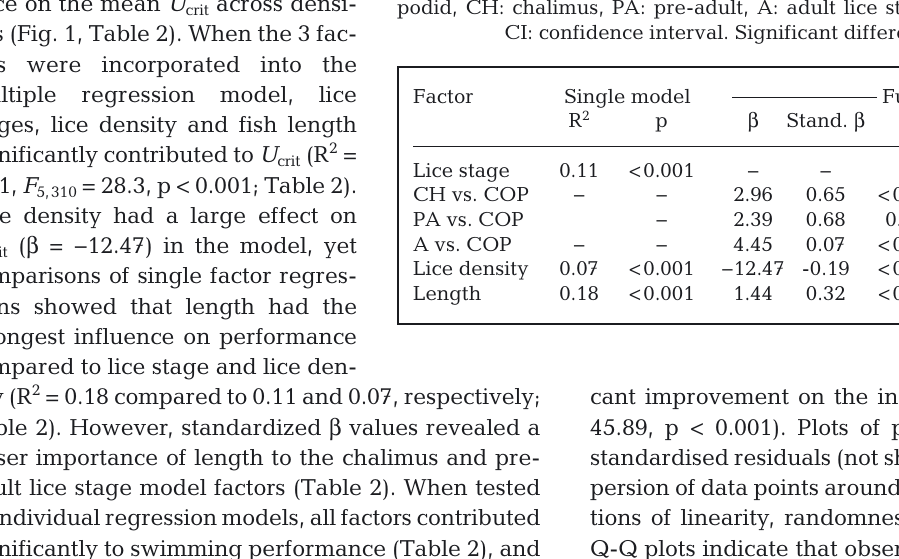
2. Model parameter outputs for the effect of sea lice ( Lepeophtheirus salmonis ) stage, sea lice density and fork length of host Atlantic salmon Salmo